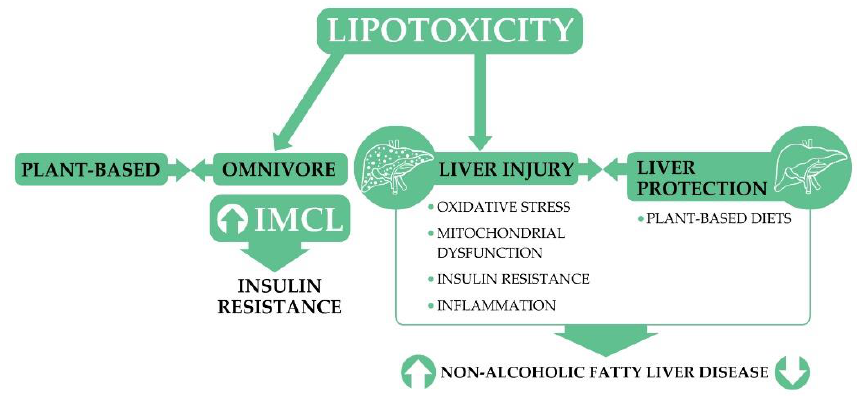
Figure 2. The potential role and consequence of plant-based diets in preventing lipotoxicity. IMCL: intramyocellular lipid.